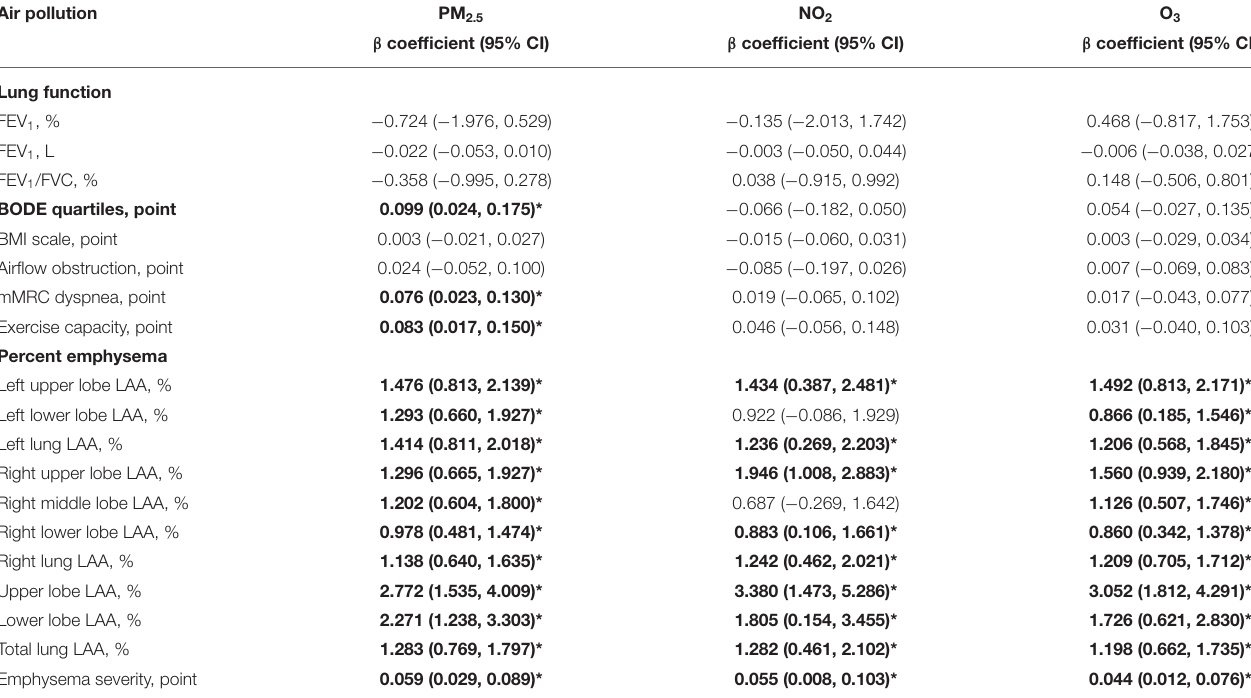
TABLE 3 | Associations between lung function, BODE quartiles, and percent emphysema (95% CI) with 1-year average air pollution concentrations of PM 2.5 , NO 2 , and O 3